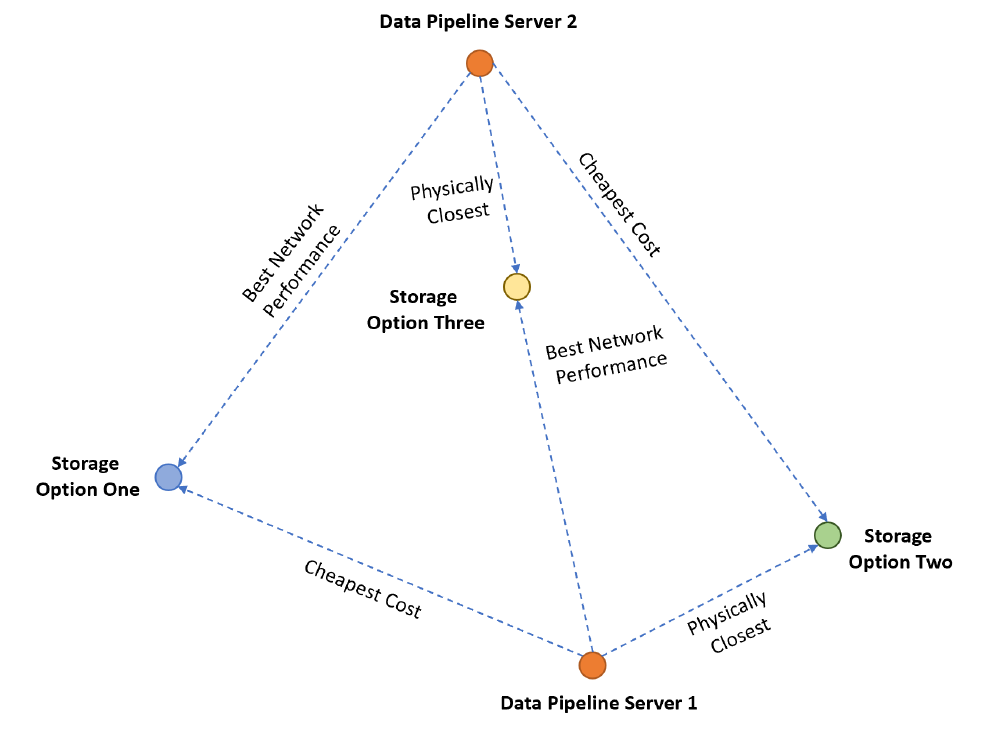
Figure 4. Relation between cost, network performance, and